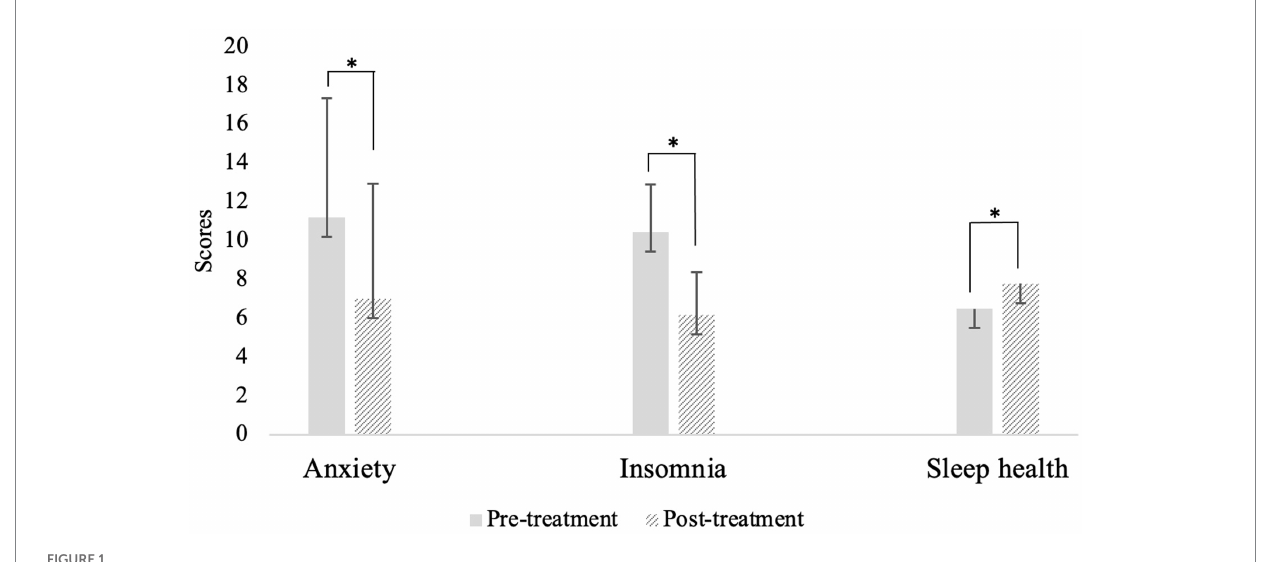
FIGURE 1 Means and standard error of anxiety, insomnia, and sleep health from pre-to post-intervention. *p <